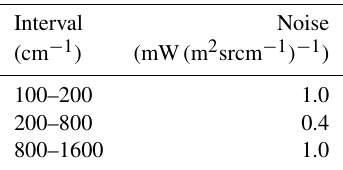
Table 2. Random noise used to simulate the Fourier transform spec- trometer of the FORUM mission.